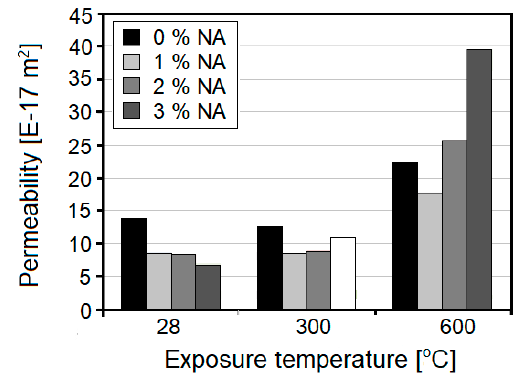
Figure 15. Permeability coefficients of cement mortars containing NA and control samples at 28, 300 and 600 °C. Reproduced with permission from [70]. Copyright Elsevier, 2013.